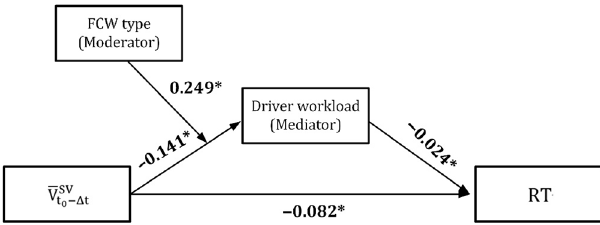
Figure 10 Mediated moderation between subject vehicle velocity and reaction time